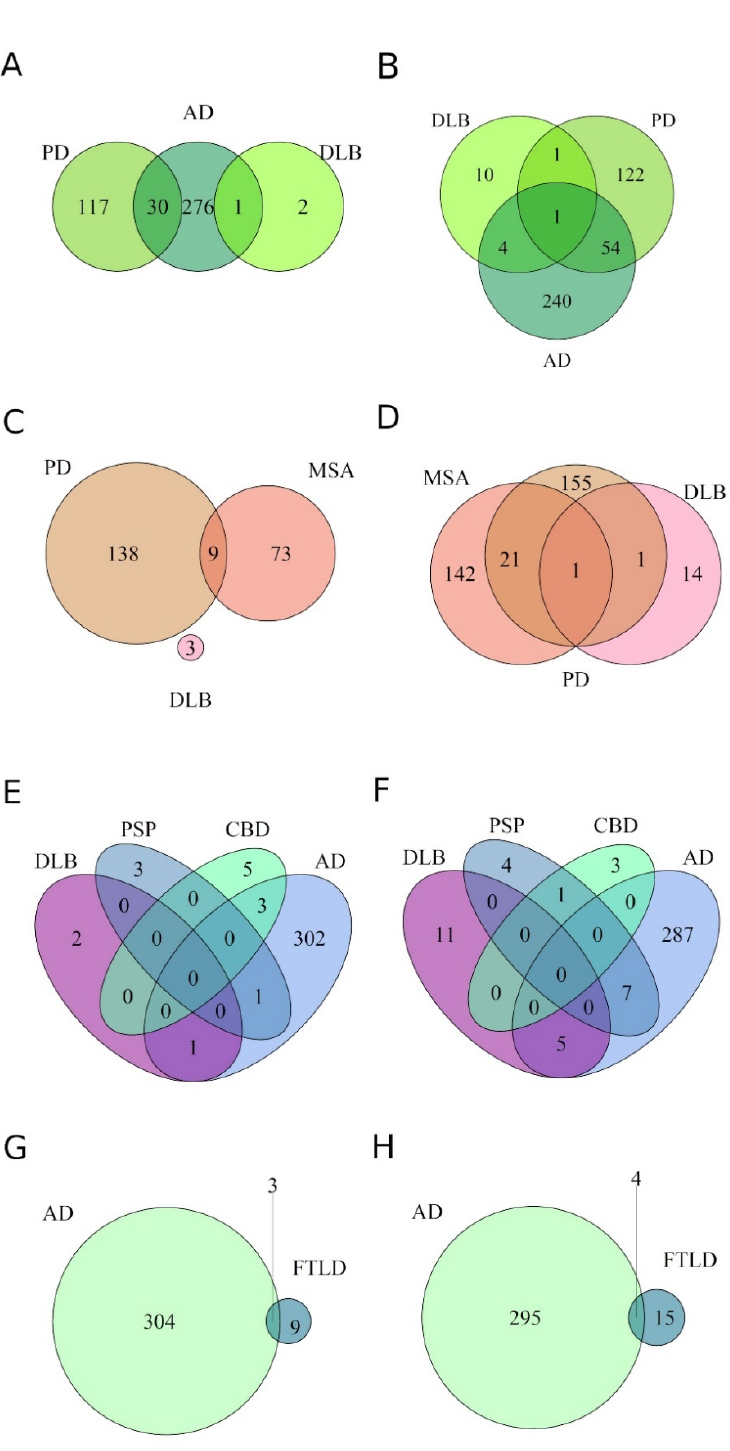
Figure 3. Venn diagrams representing the overlap of miRNAs differentially expressed in individual neurodegenerative diseases, sharing a common underlying protein pathology. Overlap is displayed between amyloidopathies ( A , B ), ɑ -synucleinopathies ( C , D ), tauopathies ( E , F ) and TDP-43 proteinopathies ( G , H ). ( A , C , E , G ) demonstrate upregulated miRNAs, while ( B , D , F , H ) demonstrate downregulated miRNAs in the individual proteinopathies. A 0–1% overlap was observed between diseases included within a single proteinopathy. ber of differentially downregulated miRNAs compared to upregulated miRNAs. MSA